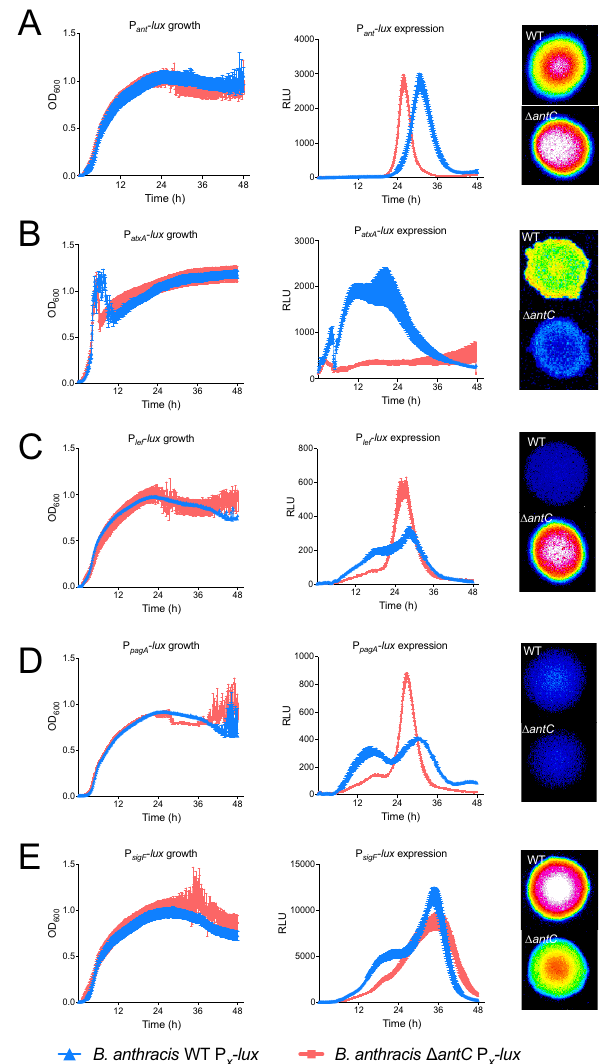
Figure 3. Luminescent expression patterns from important B. anthracis promoters are affected by anthrose status. Growth and luminescent expression experiments in HIB + Km10 were used to characterize expression of lux from the ( A ) P ant , ( B ) P atxA , ( C ) P lef , ( D ) P pagA and ( E ) P sigF promoters over 48 h. In each graph, growth (OD at 600 nm; first column of graphs) or luminescence (RLU; second column of graphs) of the Sterne WT is in blue and the Sterne Δ antC mutants is in red. Luminescent imaging of solid plate colonies at 24 h are below the broth time courses. Growth and luminescent curve data from two independent experiments carried out in triplicate with the mean and standard error of the mean at each timepoint